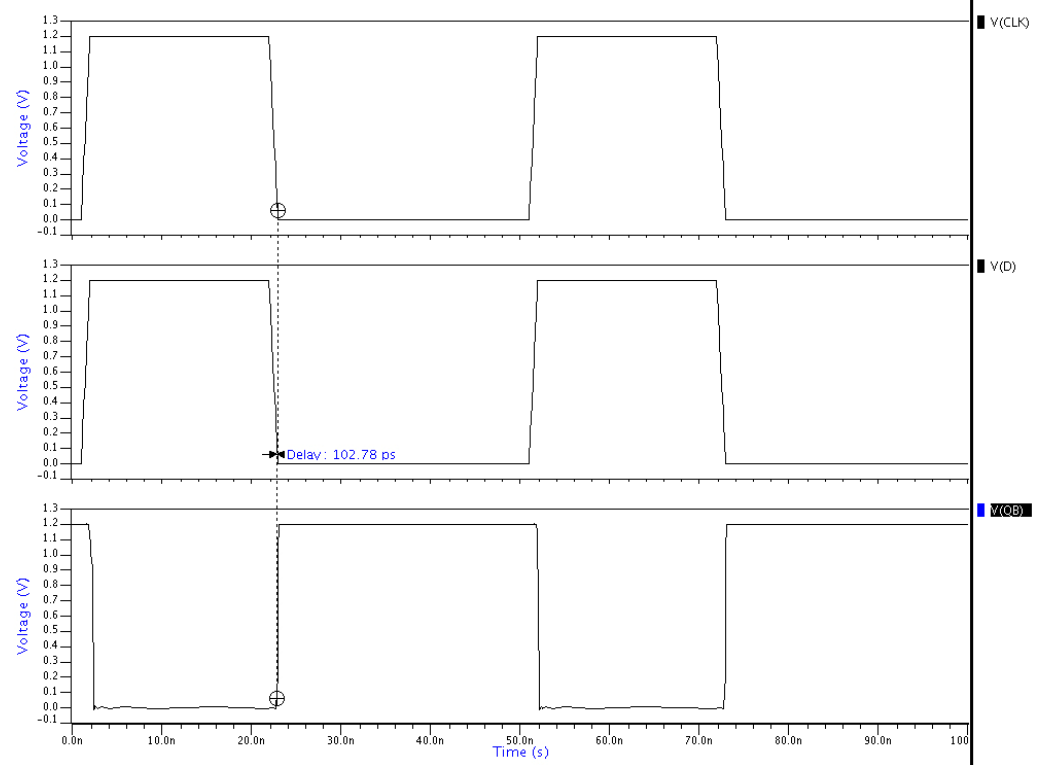
Figure 10. Current profile of the C ‐ element.